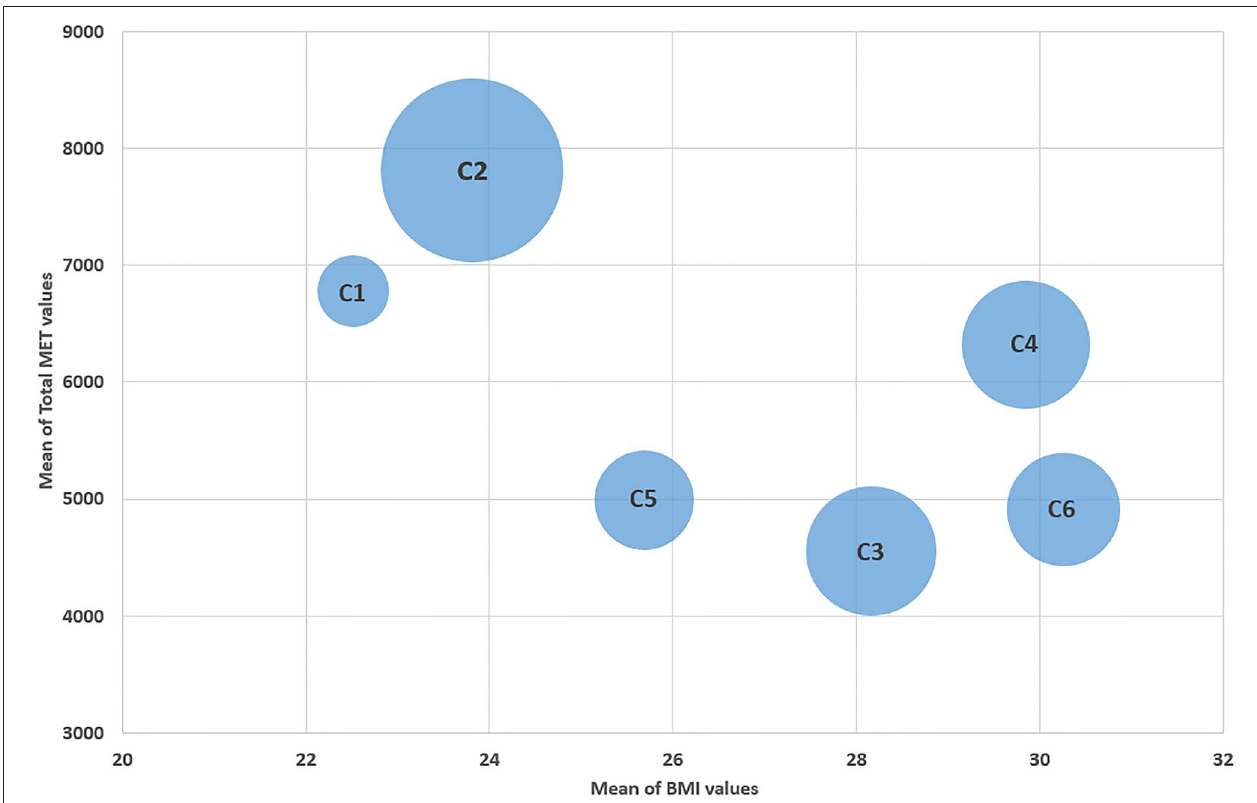
FIGURE 1 | Presentation of the clusters as a function of “BMI” and “Total MET” values. C1, Cluster 1 “Yet to leave the nesters”; C2, Cluster 2 “Working mothers”; C3, Cluster 3 “Aging but not slowing down”; C4, Cluster 4 “Physically active city-dwellers”; C5, Cluster 5 “Trendy Women”; C6, Cluster 6 “Super